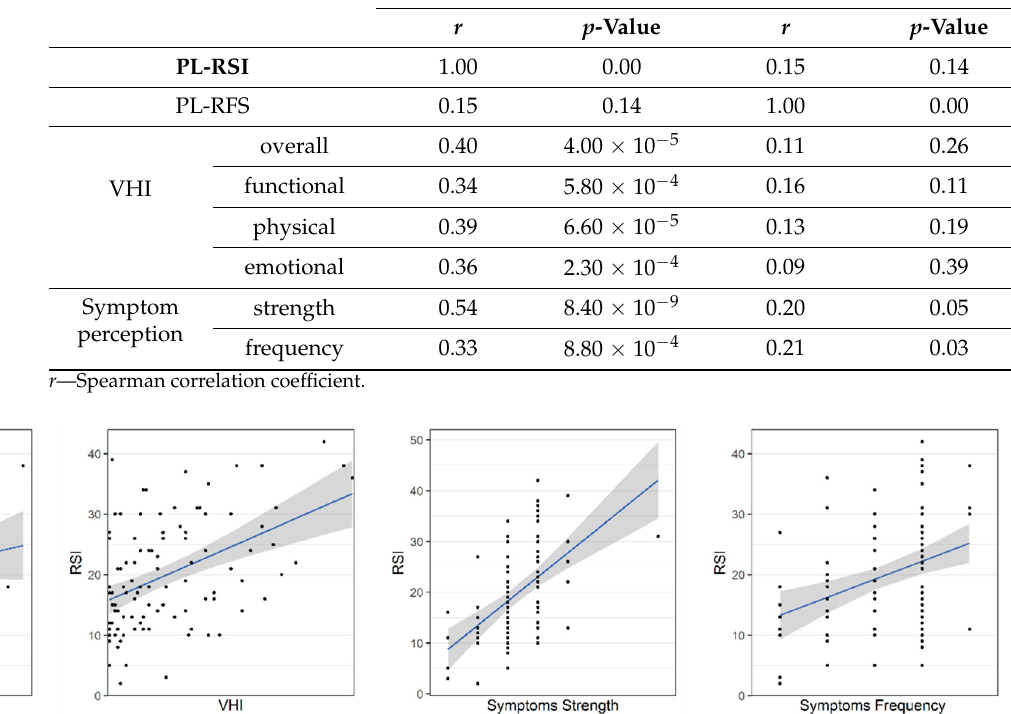
Table 7. Correlation between PL-RSI and PL-RFS scales and the other instruments evaluated. PL-RSI